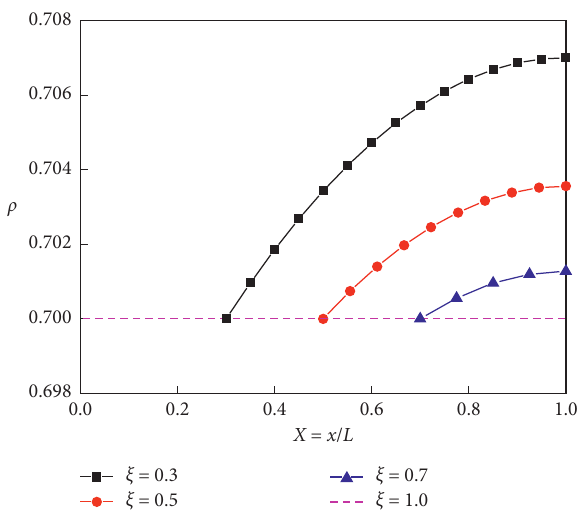
Figure 26: Effect of the interface frictional resistance at stage IV on L r